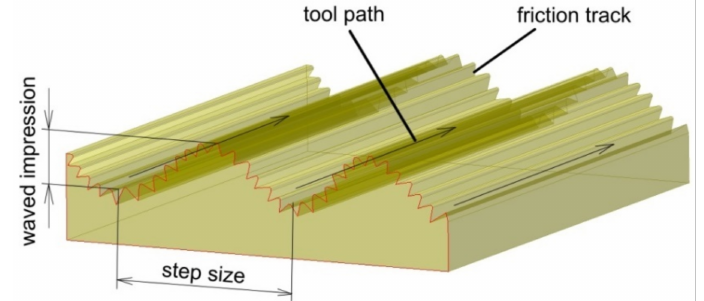
Figure 23. Surface of the drawpiece across the